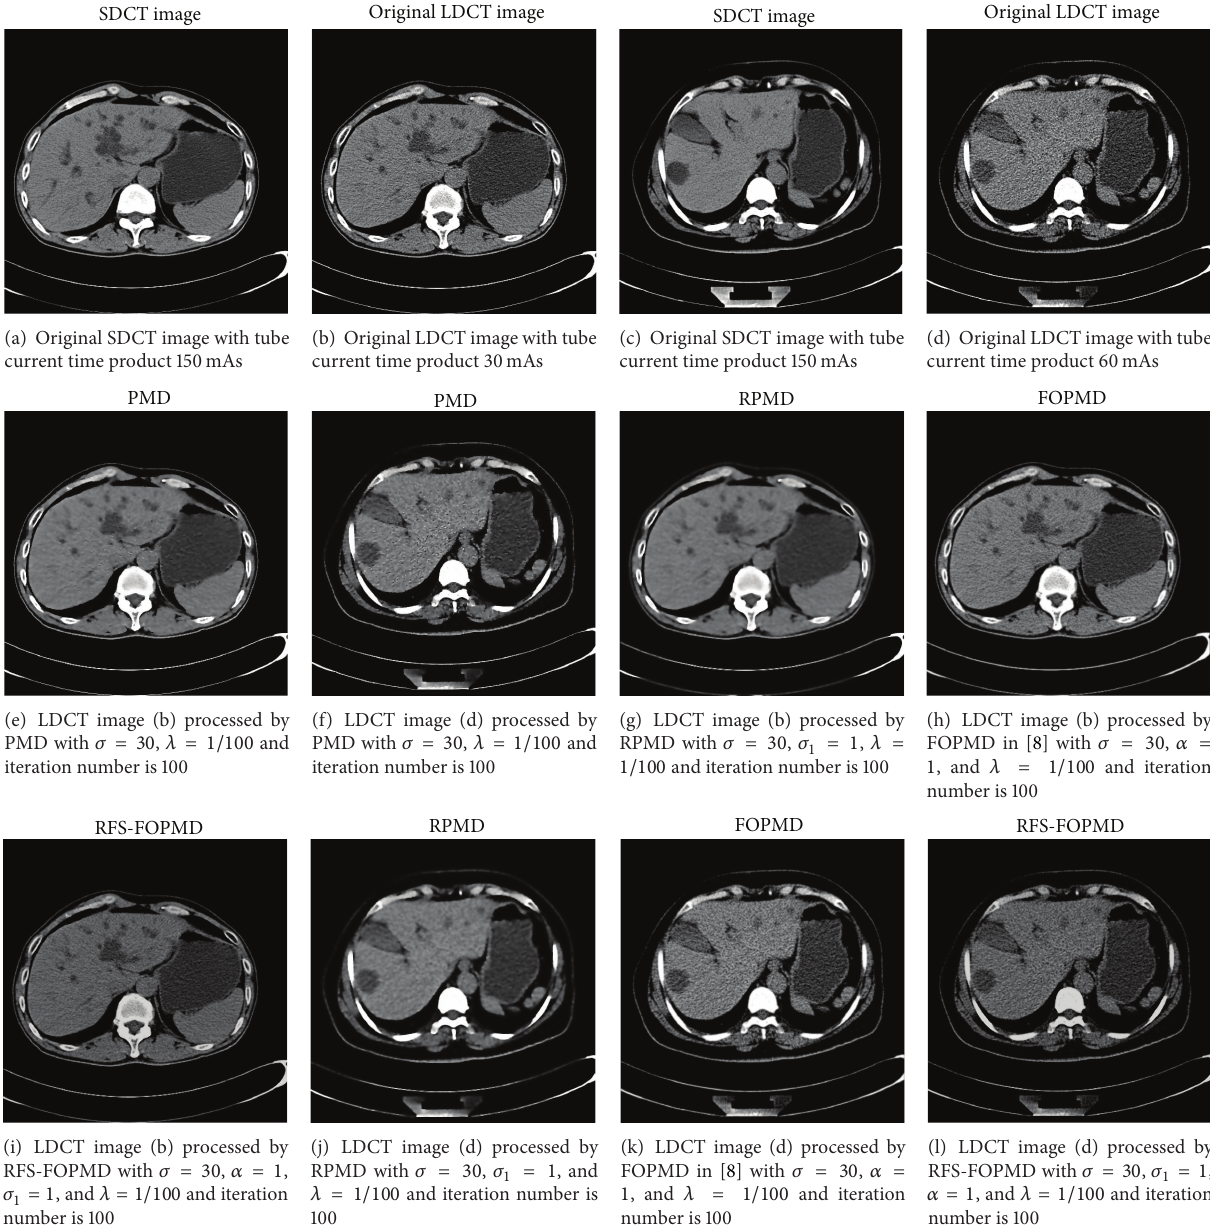
Figure 1: Original SDCT and LDCT images ((a)–(d)), LDCT images processed by PMD, RPMD, FOPMD, and RFS-FOPMD with fractional order 𝛼 = 1 and iteration number is set to